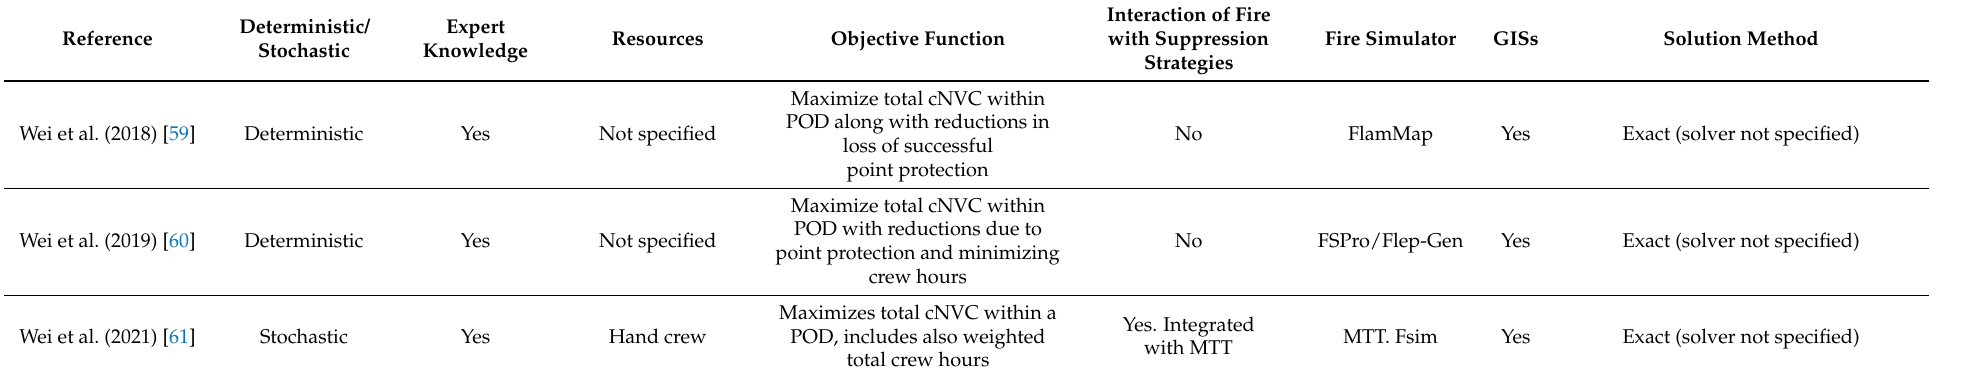
Table A5. List of main characteristics of papers that address the dispatch of resources for response. POD-based.